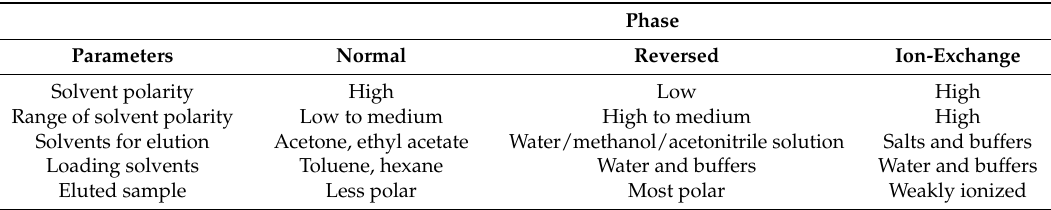
Table 1. Comparison among different solid-phase extraction